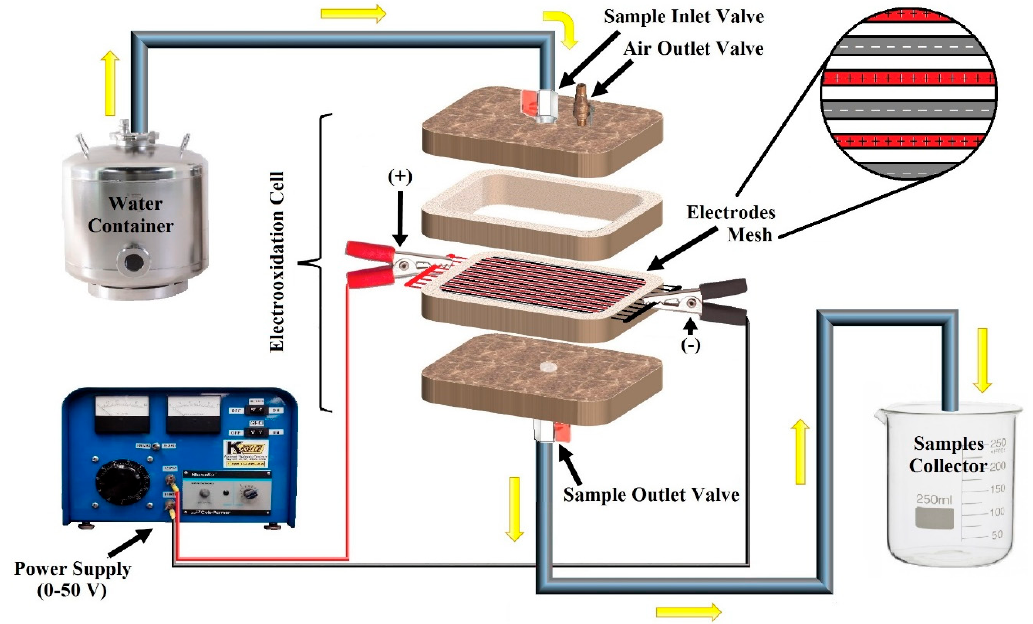
Figure 1. Schematic diagram of the innovative electrochemical oxidation cell.